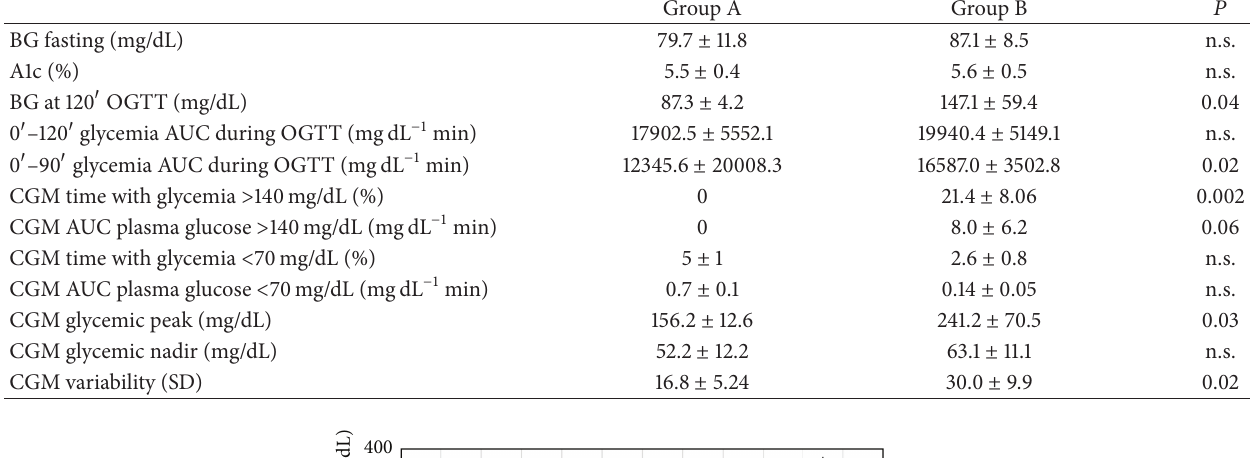
Table 2: Criteria for diabetes remission (fasting glycemia and A1c) and CGM and OGTT data in groups A and B.